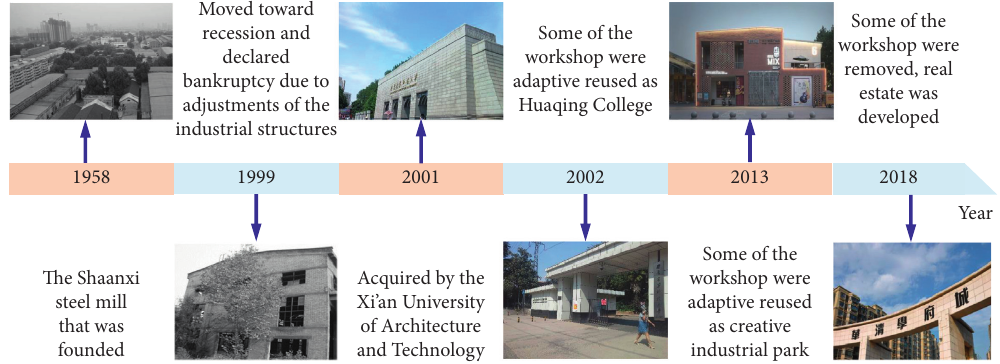
Figure 2: Adaptive reused process for the Shaanxi steel